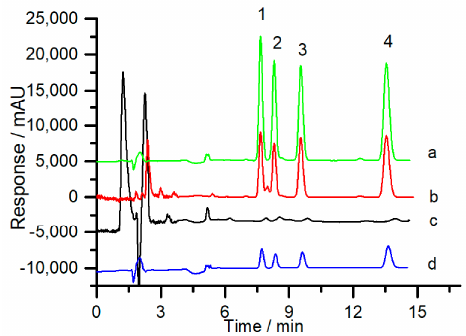
Figure 6. Chromatograms of four chlorophenoxy acid herbicides (CAHs) obtained from a spiked sample of rice grains (spiked at 200 μ g/kg) by the proposed online hydrophobic in-tube solid-phase microextraction (SPME)-HPLC method (a) using the poly (OMA-co-TRIM) monolith as the sorbent, (b) using the poly (OMA-co-EDMA) monolith as the sorbent, (c) by direct injection mode of HPLC, and (d) obtained from practical sample of rice grains by the proposed online hydrophobic in-tube SPME-HPLC method using the poly (OMA-co-TRIM) monolith as the sorbent. SPME operating parameters: The length of the monolithic column, 12 cm; sampling solution, 0.1% TFA aqueous solution / ACN = 98 / 2 ( v / v ); sampling flow rate, 0.10 mL / min; sampling time, 5 min; elution flow rate, 0.10 mL / min; elution volume: 400 µ L. Peak identifications: 1: 2,2-CPPA; 2: 2,3-CPPA; 3: 2,4-D; 4: 2,4-DP.